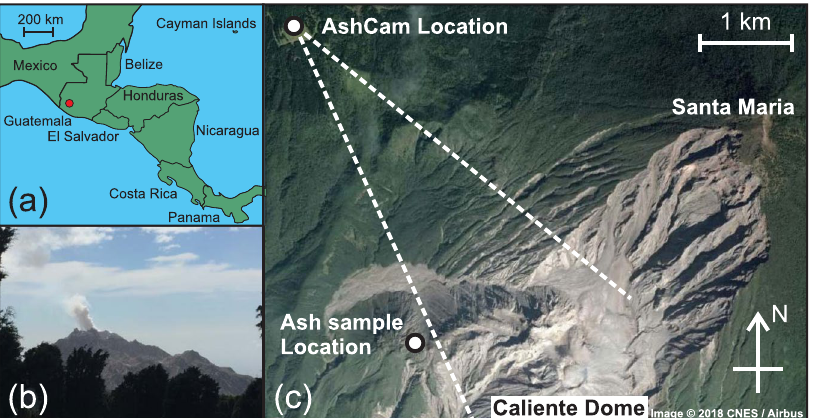
Figure 1. Geography of Santiaguito. ( a ) Sketch map showing the location of Santiaguito in Central America (red circle). ( b ) Image of Caliente dome taken from the measurement location at the onset of an explosion (image taken by Ben Esse). ( c ) Satellite image of the area surrounding Santiaguito with the measurement and sample locations marked. The dome complex can be seen to be growing from the collapse scar of Santa Maria. The dotted white lines give the approximate field of view of AshCam. Map data: Google, CNES/Airbus. Map generated with Google Earth version 7.1.8.3036